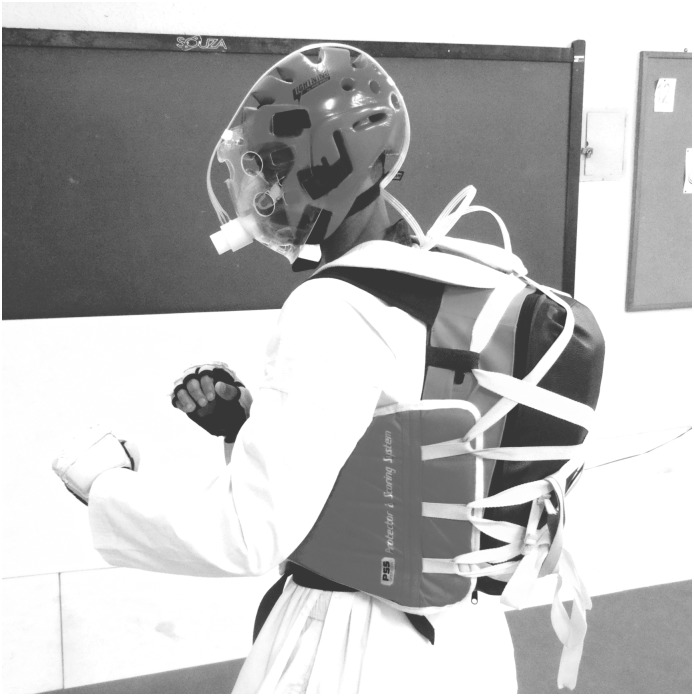
Gas analyser placement during the combat.